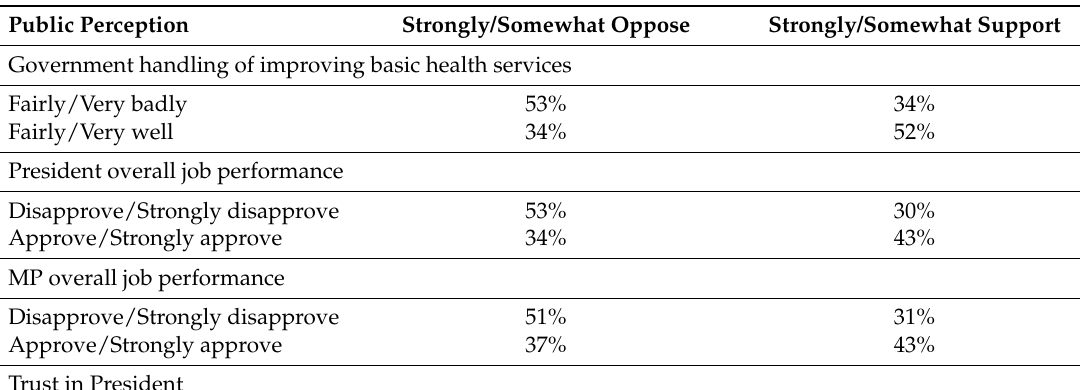
Table 3. Support for taxes/fees for health spending.